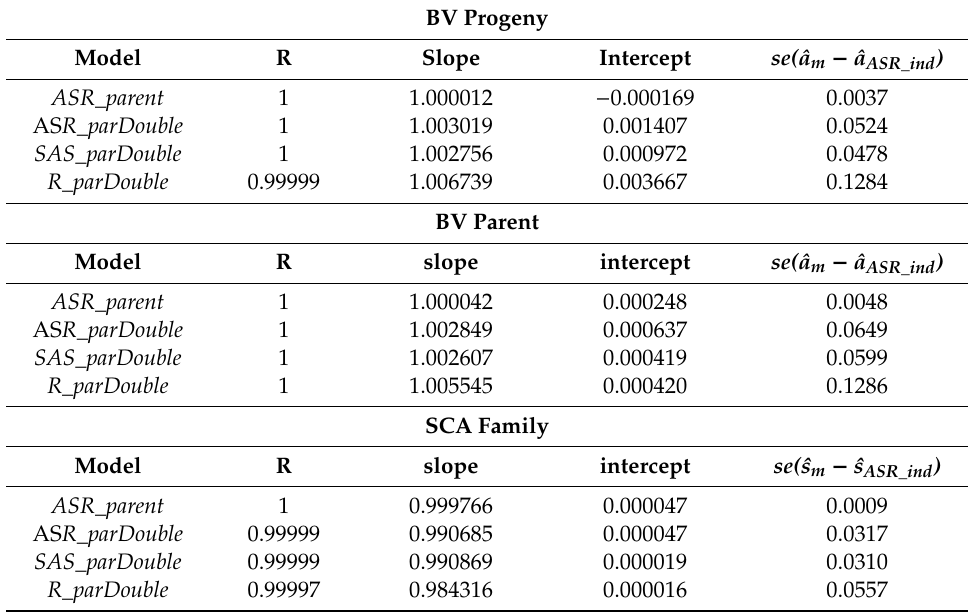
Table 7. Relationships between BLUPs from ASR_ind and other linear mixed model BLUPs 1 for parental breeding value, full-sib family SCA, and individual tree breeding value. Statistics are R = correlation, linear regression slope, linear regression intercept, and se(ˆg k − ˆg ASR_ind ) = standard error of di ff erence between BLUPs, where â = breeding value prediction, ˆs = SCA prediction. Analyses for a simulated full-sib progeny dataset with 40 parents, 80 families from an unbalanced mating design, 4 tests, and 25 trees / family /